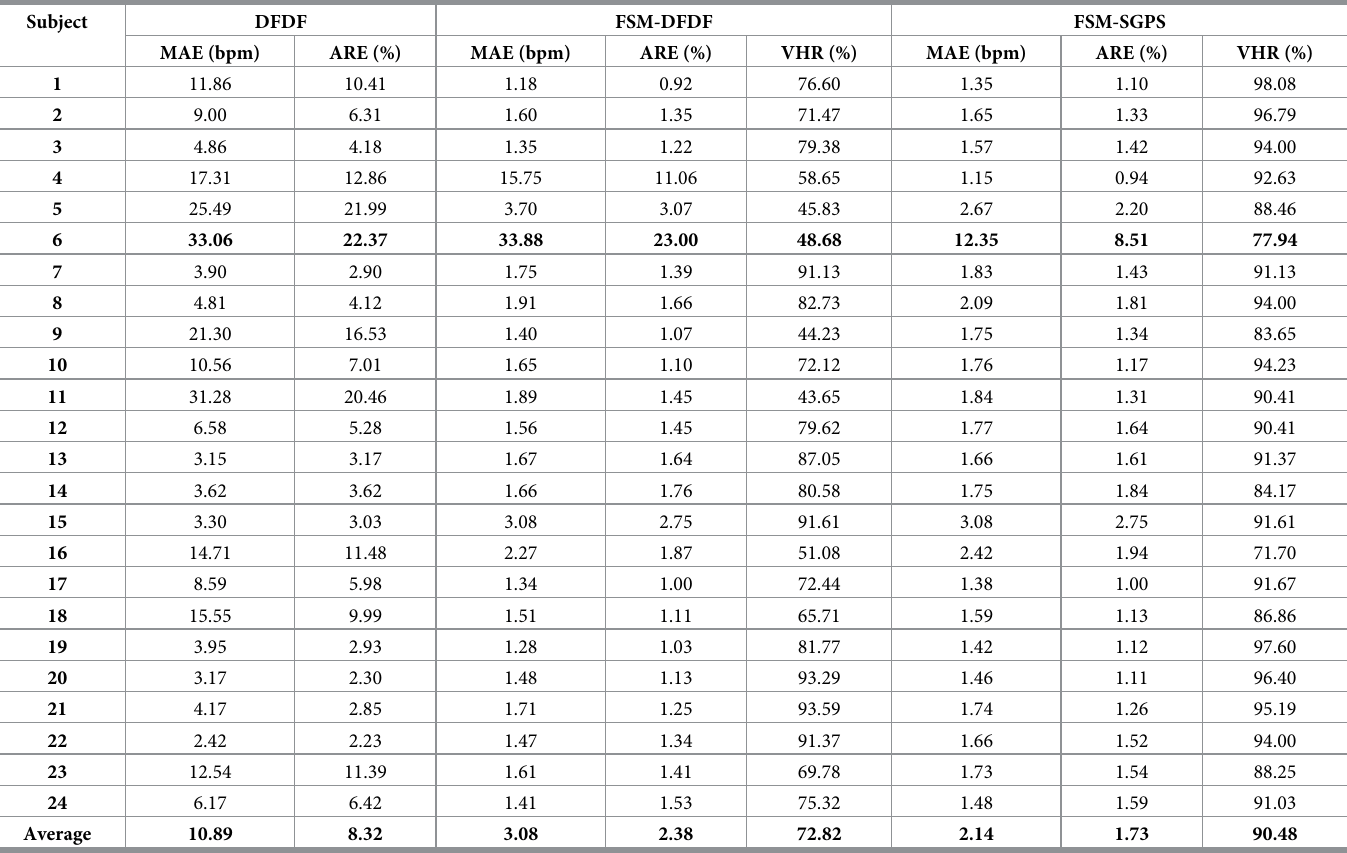
Table 5. Performance comparison of the DFDF, FSM-DFDF, and FSM-SGPS HR estimation methods for the 24 subjects of the BAMI